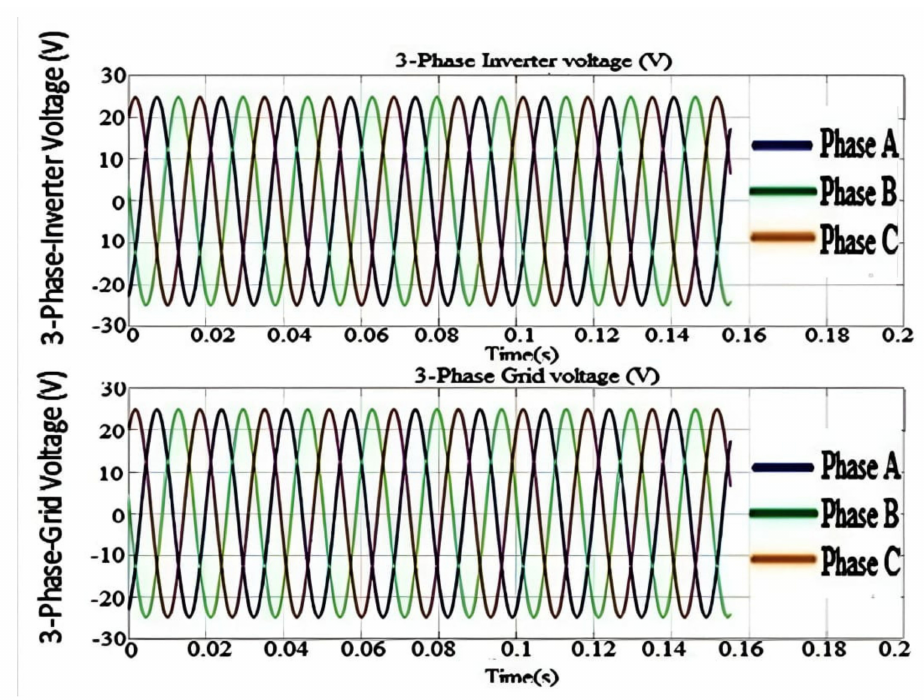
Figure 25. The three-phase grid and inverter current of the fuzzy-PI controller. There are two and a half divisions; each division = 10 V, therefore, V P = 25 V, and √ output phase voltage (V) (R.M.S) = 25/ 2 = 17.6 V. The specifications for the hardware design and power rating of the inverter as shown in Table